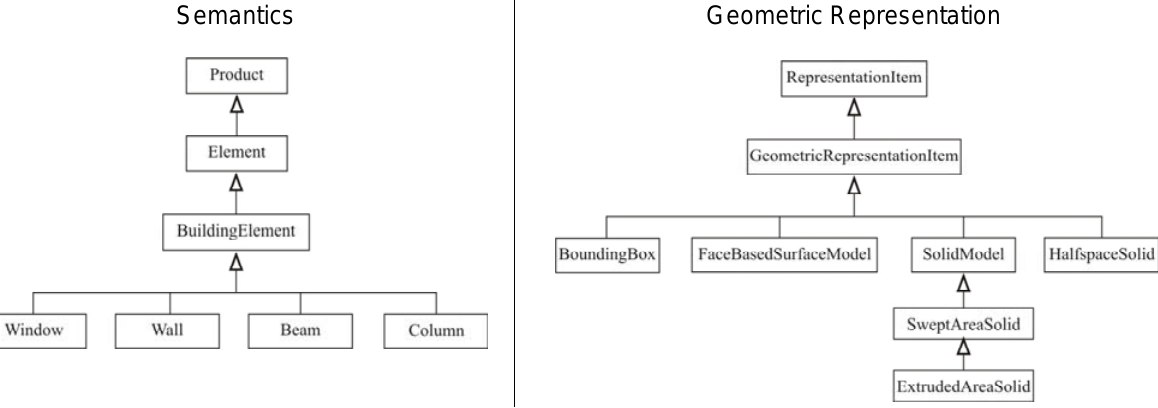
Figure 4. Separation of geometry and semantics in the IFC data model; different geometry representations provided by the IFC